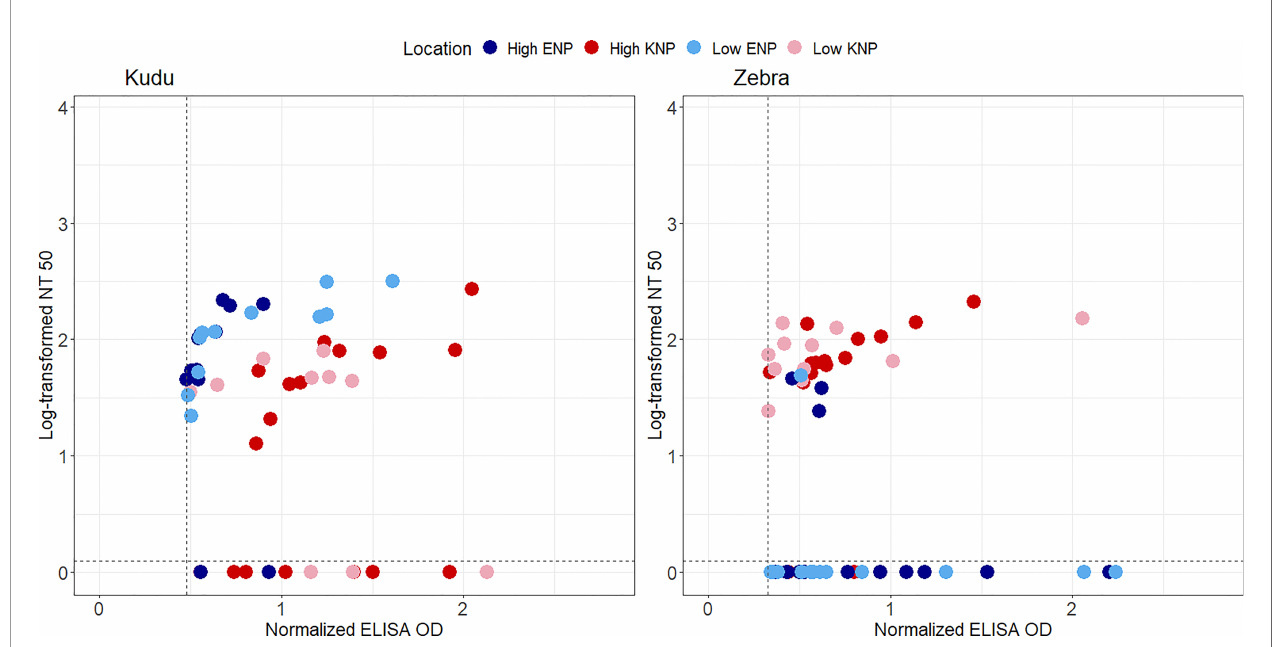
FIGURE 6 | Scatter plots representing log-transformed neutralization titre 50 (NT 50 ) and normalised anti-protective antigen (PA) enzyme-linked immunosorbent assay (ELISA) optical densities (ODs) for greater kudu ( Tragelaphus strepsiceros ) and plains zebra ( Equus quagga ) from Kruger National Park (KNP) in South Africa and Etosha National Park (ENP) in Namibia. The NT 50 was calculated as the highest titre that protected 50% of the mouse macrophage cells. Shapes and colors of marker points represent different parks (blue circle: ENP, red triangle: KNP), and variation in color shades indicate study area that differs by anthrax incidence (dark: high incidence, light: low incidence) in each park. TNA negative sera (samples that could not protect 50% of the macrophages) are seen below the dotted horizontal lines in each plot. Only samples that were anti-PA positive are shown as others were assumed to not have been exposed to Bacillus anthracis (the threshold for anti- PA positive is shown with the dotted vertical line). The locations of high and low incidence areas in each park are shown in Figure 1